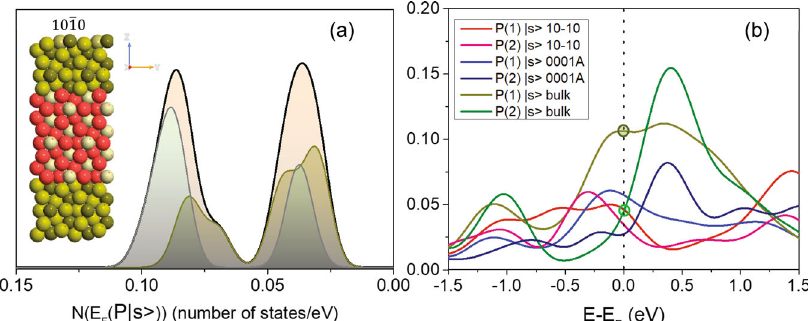
Fig. 3 DFT calculated pDOS at the Fermi level. a The phosphorous s-electrons pDOS distribution at the Fermi level N ð E F ðj s > ÞÞ of the ð 10 (cid:1) 10 Þ terminating slab. The inset shows the relevant 54-atoms super-cell, where the dark green and light green spheres represent the surface P and Ni respectively, while the red and gray spheres represent the bulk Ni and P. b The s-electrons pDOS of the P(1) and P(2) atomic positions in three different con fi gurations: the (0001 A), ð 10 (cid:1) 10 Þ , and bulk Ni 2 P. Circles indicate the pDOS values for bulk P(1) and P(2) atoms.